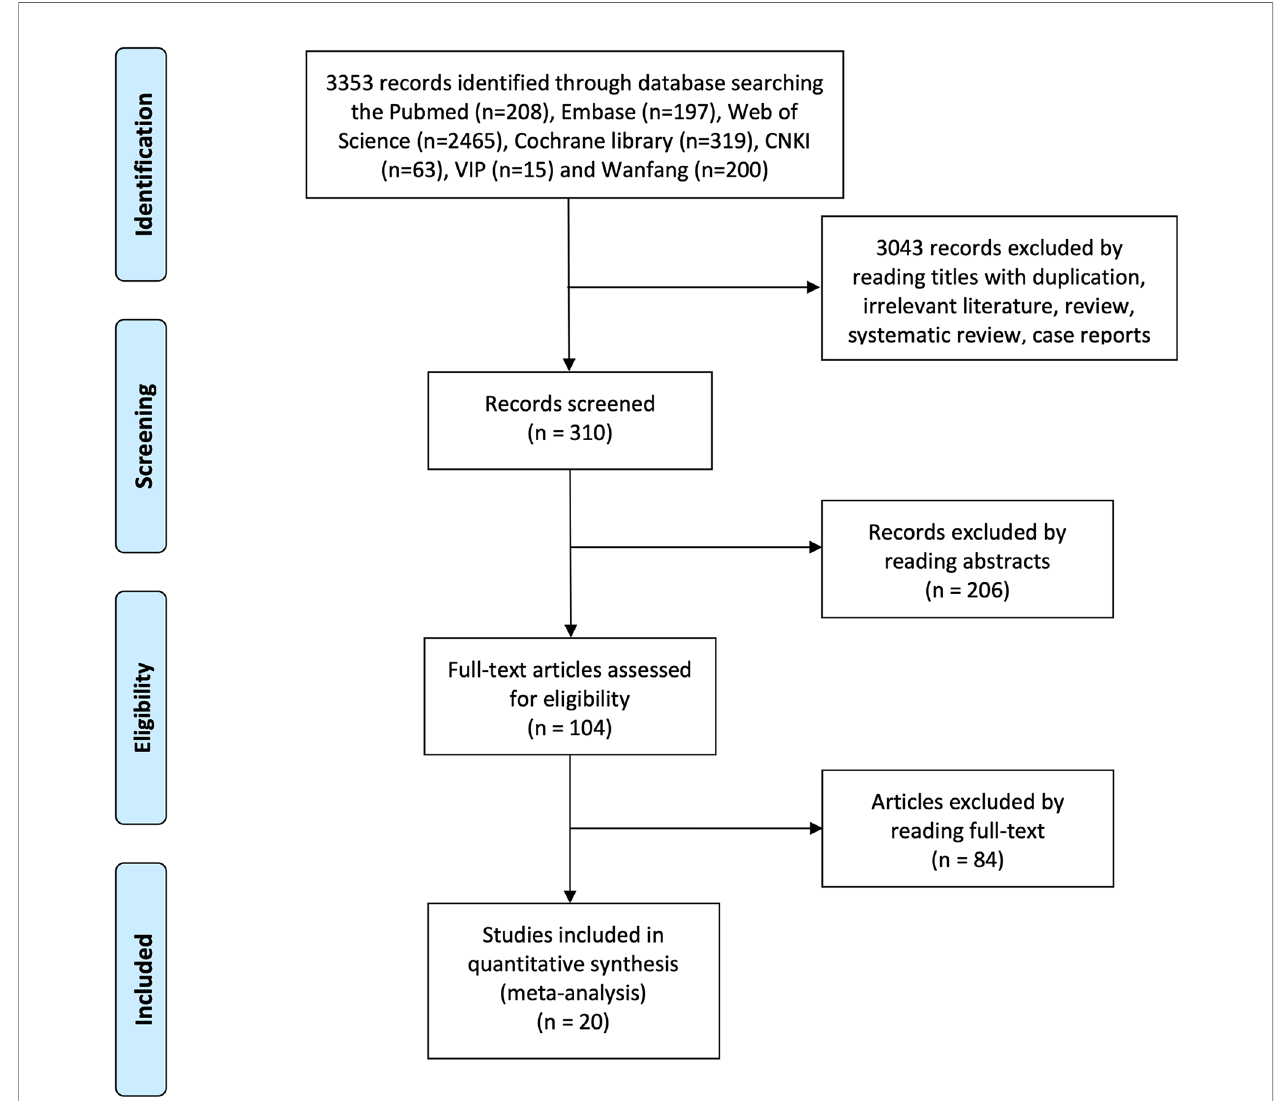
FIGURE 1 | Flowchart illustrating the study selection of downstaging prior to